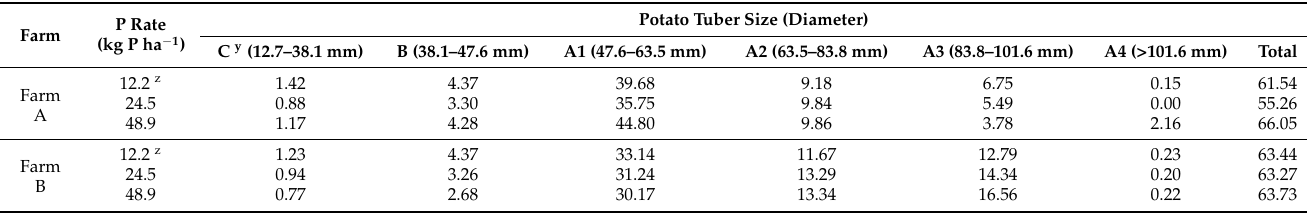
Table 11. Tuber size of ‘Atlantic’ chipping potato grown on Farms A and B with different P